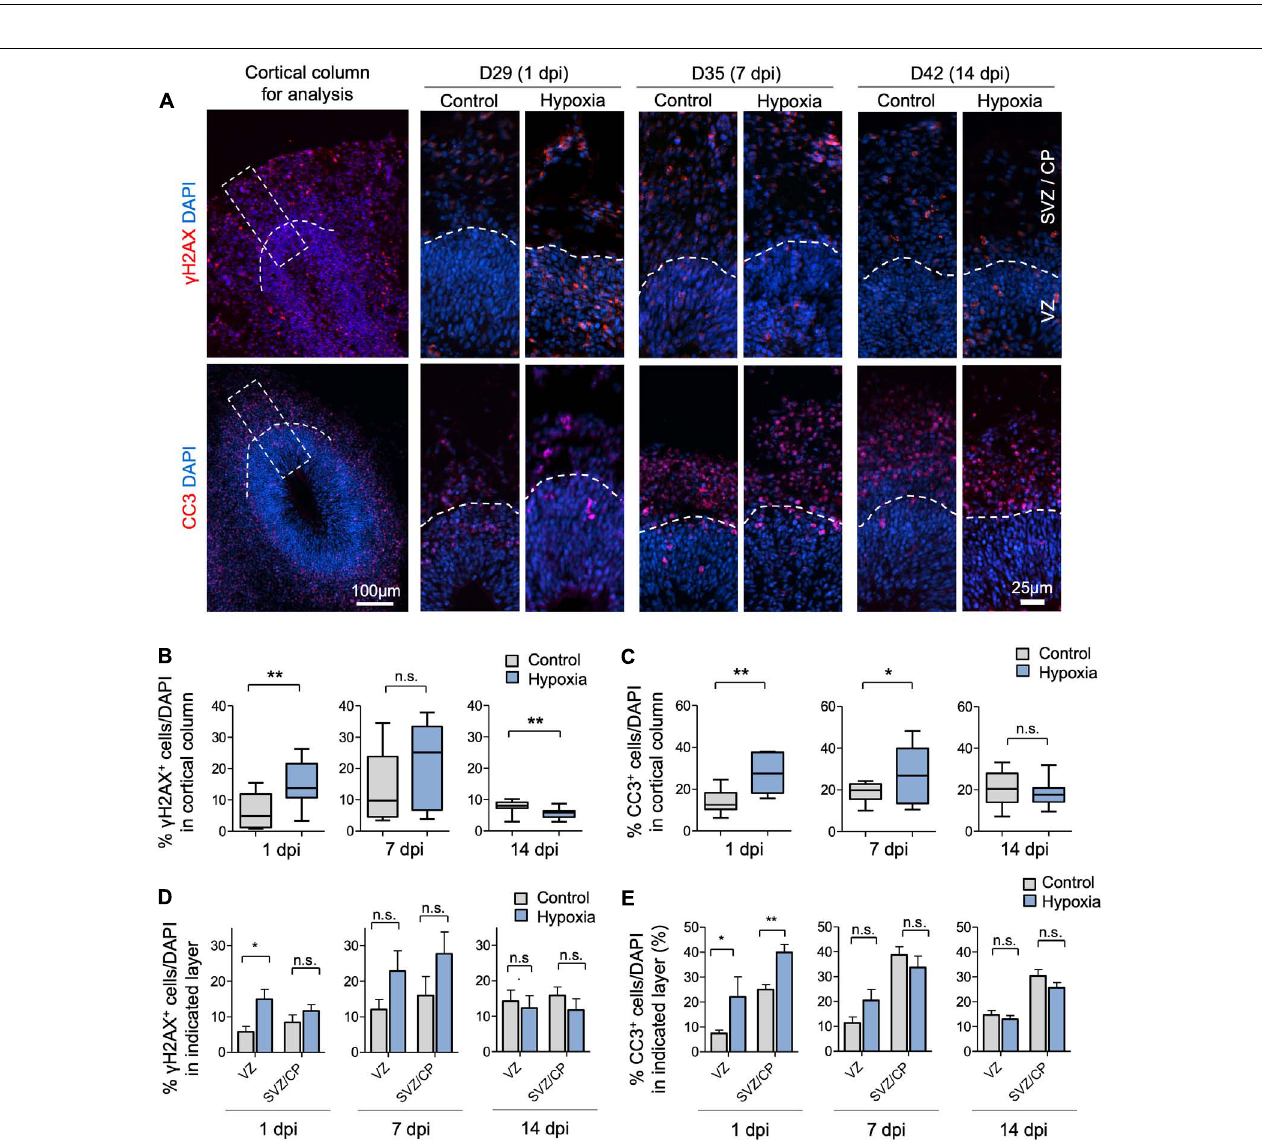
FIGURE 1 | Transient hypoxia model in human cerebral organoids. (A) Schematic diagram of transient hypoxic injury (HI) model with hESC-derived cerebral organoids. D0 represents the starting day of differentiation, D14 denotes the time when organoids were transferred to culture on orbital shaker. At D28, organoids were subjected to 3% O 2 in a hypoxic chamber for 24 h, followed by return to 21% O 2 culture condition for the remaining culture periods until analysis. (B) IF images for the indicated markers in cerebral organoids demonstrate progressive development of cortex-like structures and appearance of immature neurons (TUJ1 + ) and deep-layer cortical neurons (CTIP2 + ) from D14–D42. Proliferating (Ki67 + ) NSCs (PAX6 + ) reside in VZ-like germinal region, and offspring in various stages of differentiation migrate out of VZ to populate outer layers, designated as SVZ/CP-like structures. White dashed lines delineate border between VZ and SVZ/CP. Note higher cellular density in the VZ as visualized by DAPI nuclear counterstaining. (C) Left, IF images demonstrate progressive development of oRGs that express FAM107A. Right, schematic depiction of spatial localization of FAM107A + oRGs during human brain development at the indicated gestational week (GW), adapted from Pollen et al. (2015). (D) Representative IF images show stabilization of HIF-1 α at D29 (1 dpi) after hypoxia episode as compared to control, while only baseline HIF-1 α immunofluorescence was detected at D42 (14 dpi). High magnification images of boxed areas are shown on the right.